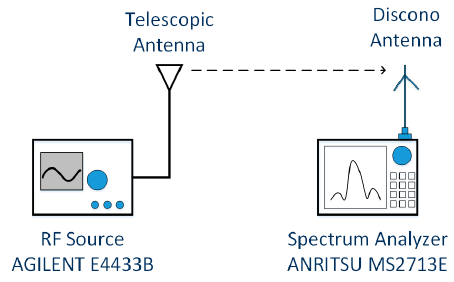
Figure 4. Small building measurement system: receiver system and transmitter system.